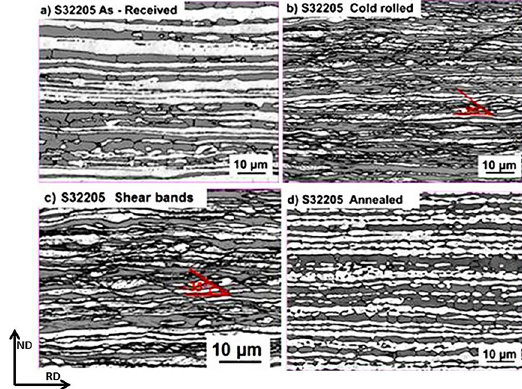
Figure 1. Microstructure of the duplex stainless steels S32304; a) as received, b) cold rolled (CR) and c) annealed